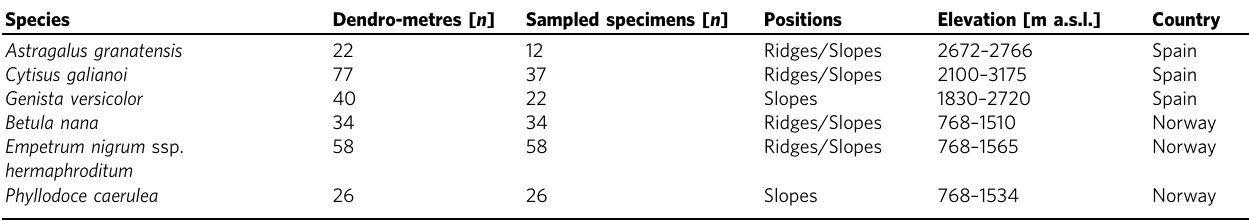
Table 1 Shrub species and their characteristics.